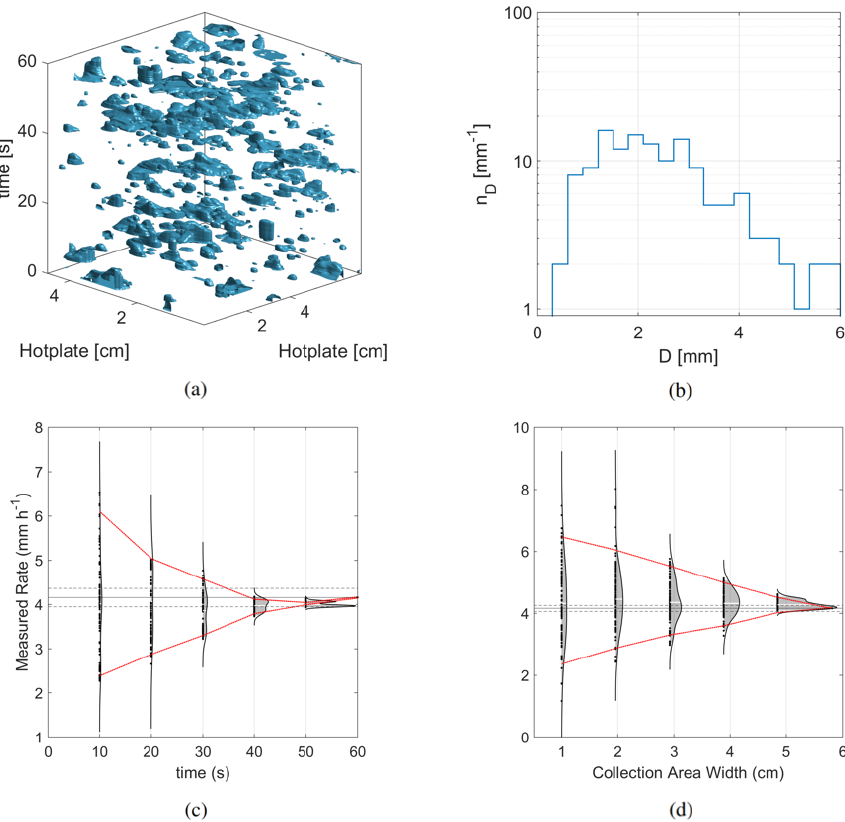
Figure 5. Recalculation of R calc (Eq. 7) from 1000 uniformly distributed, randomly sampled iterations of a 1min DEID dataset from 8 March 2020 at 14:43MST with rain rate R DEID = 4.2mmh − 1 (a) . R calc was recalculated using uniformly distributed random segments of time (c) and hotplate sampling area width (d) . As t → 60 and W → W DEID , R calc approaches R DEID